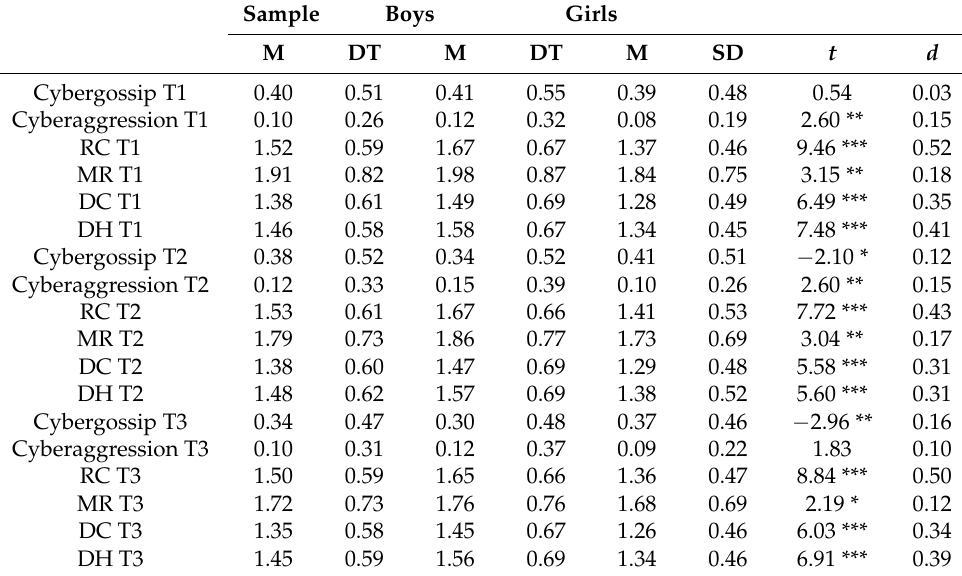
Table 1. Means, Standard Deviations, and differences by gender for all variables. Sample